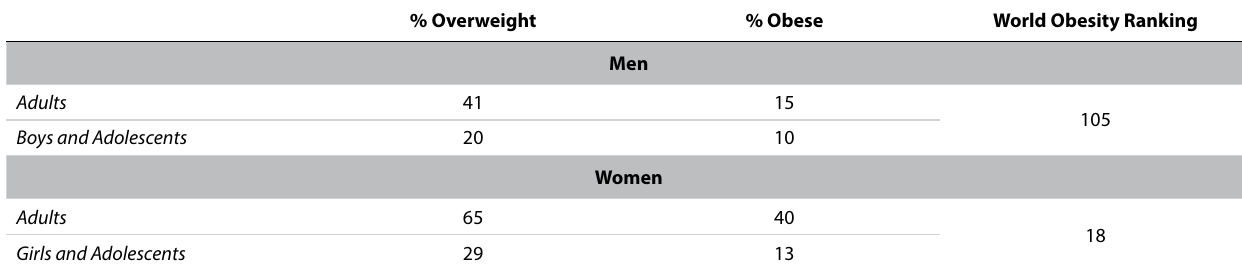
Table 1 - Percentages of the South African population that are overweight and obese, respectively Adapted from 6 % Overweight %